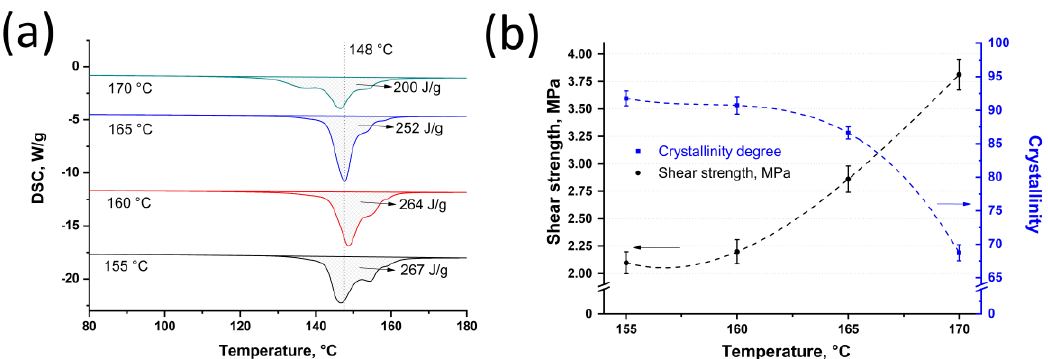
Figure 3. Results of differential scanning calorimetry (DSC) curves ( a ) and shear strength of hybrid composites and crystallinity ( b ) of the self-reinforced composites based on UHMWPE produced at 25 MPa and various temperatures.